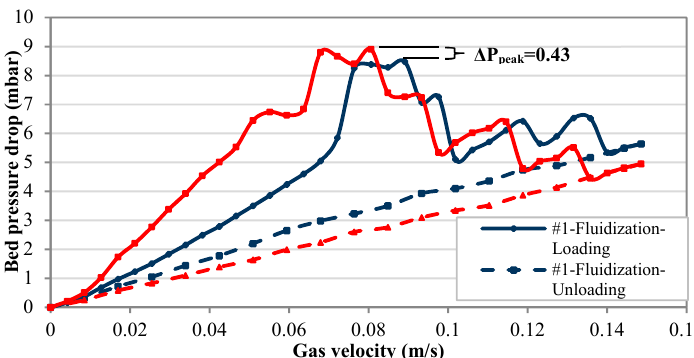
Figure 6. Fluidization and re-fluidization behaviors (after compression at 40 kPa, intermediate pressure) for ultra-fine powder (CALCIT MX 10).